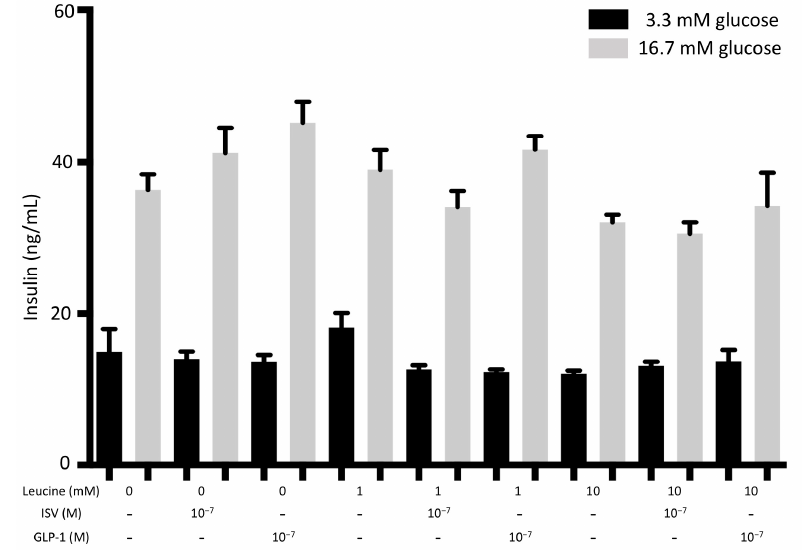
Figure 7. Effects of 10 − 7 M ISV and 10 − 7 M GLP-1 on insulin secretion in leucine-treated INS-1E cells. After 72 h of incubation with or without 10 − 7 M ISV and 10 − 7 M GLP-1, in the medium containing 1 mM or 10 mM palmitic acid, INS1-E cells were stimulated with low (3.3 mM) and high (16.7 mM) glucose. Subsequently, insulin secretion was measured. Data are presented as the mean ± SEM of 18 samples per group from three independent